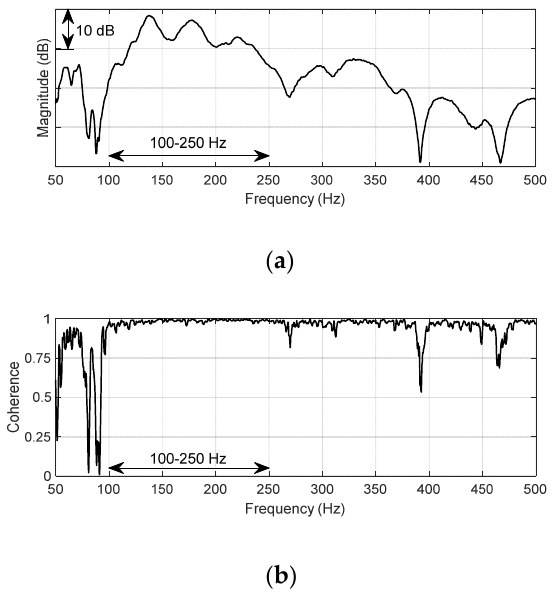
Figure 5. Frequency response of the secondary path between the ESG and the error microphone. ( a ) Magnitude response. ( b ) Coherence. ( a ) Magnitude response. ( b )